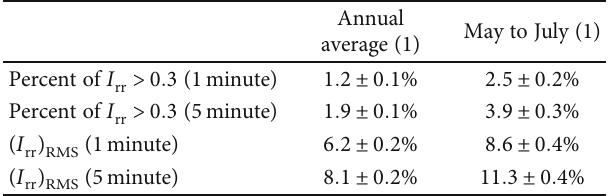
Table 2: Frequency and magnitude of ramp rates in solar irradiance between 8 am and 8 pm over the entire years as compared to three spring/summer months illustrating the expected trend of larger variability during the higher solar resource